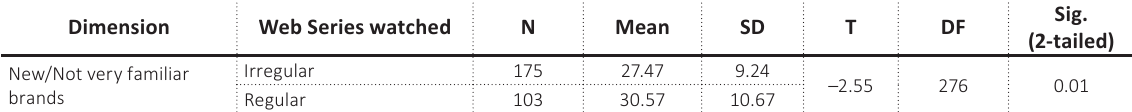
Table 5. Differences in responses of Web Series viewers in the recall of new brand names